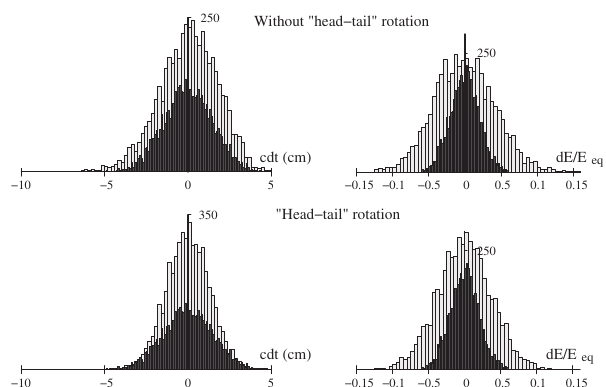
FIG. 6. The evolution of the distribution of the arrival time and the relative energy after passing through 5 rods in cases of head- tail rotation usage and without it; j —initial distribution; h — distribution after passing 5 rods.